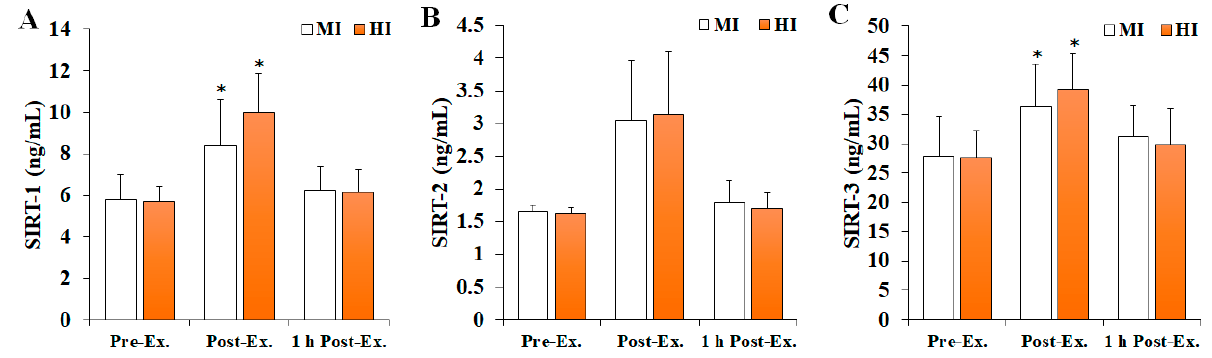
Figure 3. The changes in SIRT levels after treadmill running at different exercise intensities. Values are presented as mean ± SD. ( A ) SIRT-1: sirtuin 1, ( B ) SIRT-2: sirtuin 2, ( C ) SIRT-3: sirtuin 3, MI: moderate-intensity, HI: high-intensity, Ex: exercise, * significant difference with pre-exercise and 1 h post-exercise within group ( p < 0.05).